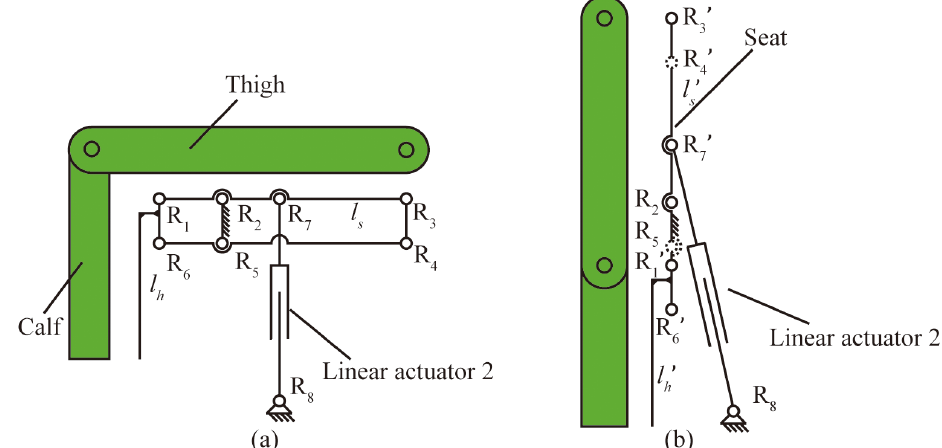
Figure 7. The configuration of the seat module. (a) Schematic diagram of the seat module at the sitting posture. (b) Schematic diagram of the seat module at the standing posture.